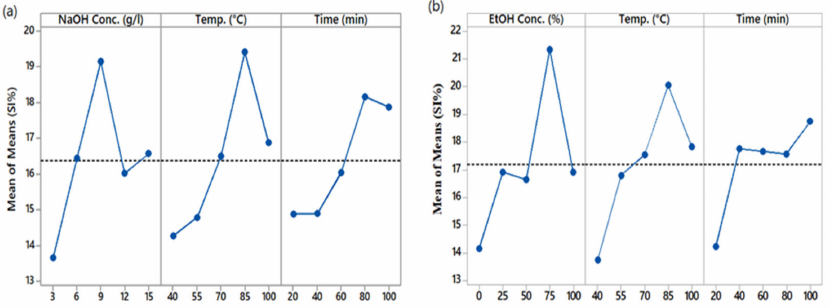
Figure 3. Main effect plots of SI% ( a ) NaOH, ( b )